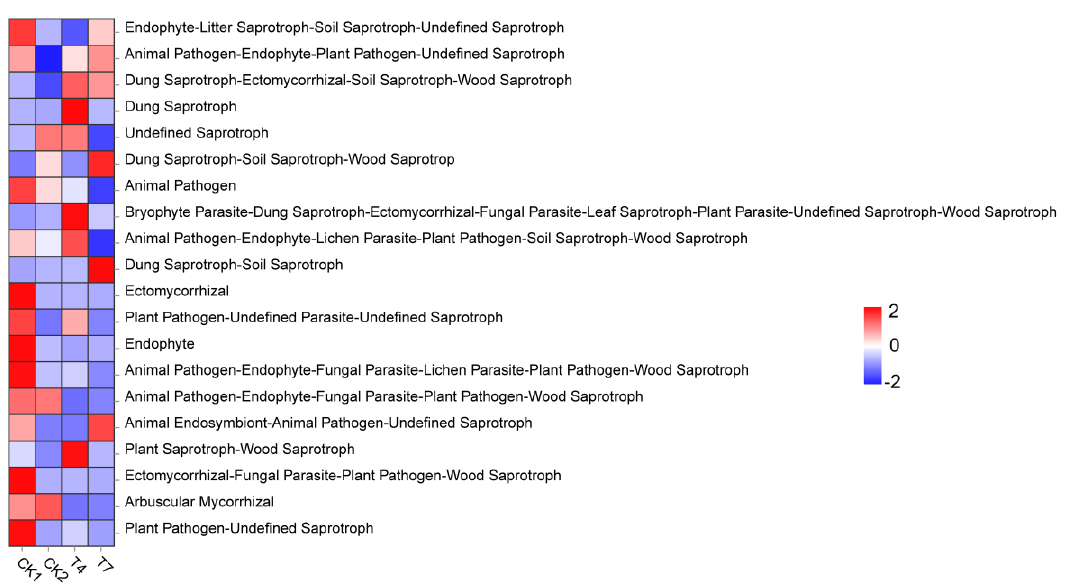
Figure 7. Prediction of fungal functions in different treated soils based on FUNGuild.